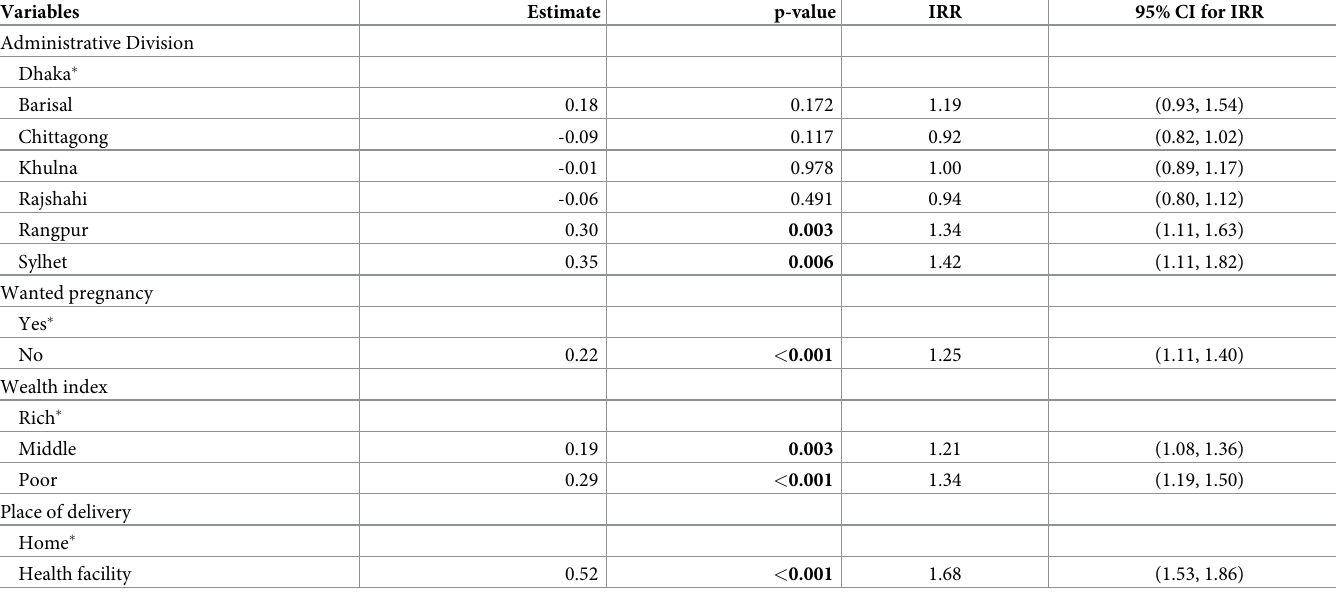
Table 5. The results of the final multivariable negative binomial regression model to identify maternal morbidity determinants during pregnancy in urban